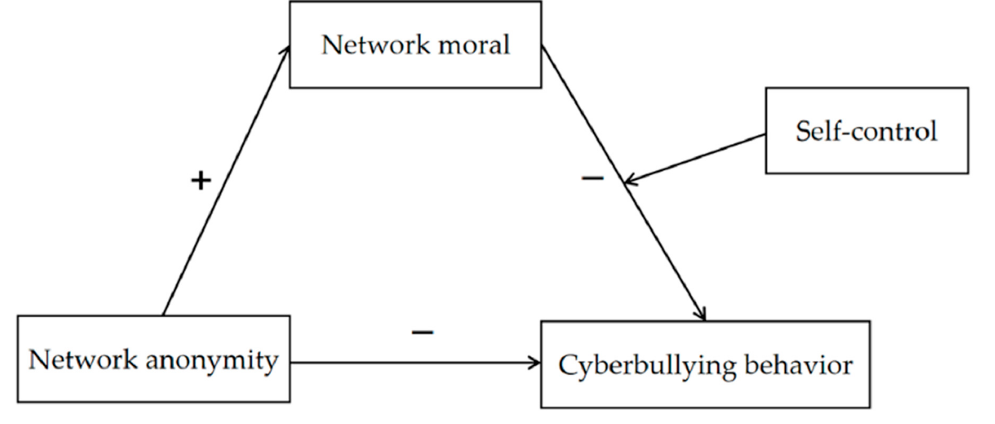
Figure 1. Hypothetical model.